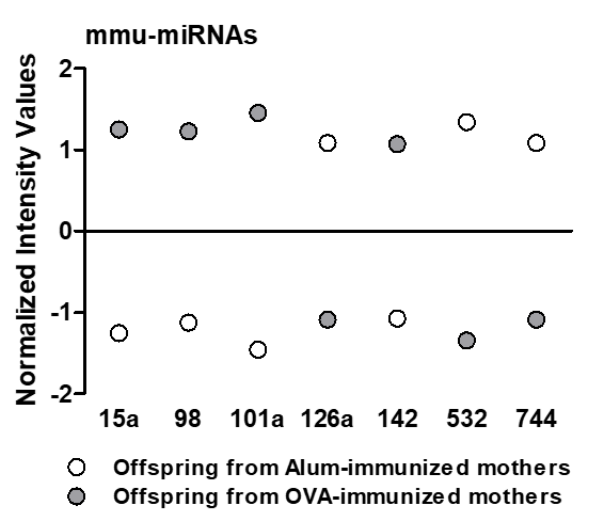
Figure 4. miRNAs that were substantially modulated between groups. The thymus of offspring from OVA-immunized ( n = 10) or Alum-immunized ( n = 11) mothers was evaluated at three days old. The dots showed the seven dysregulated miRNAs between offspring from Alum and OVA-immunized mothers. The fold change in these miRNAs was set at cut-off ≥ 4.